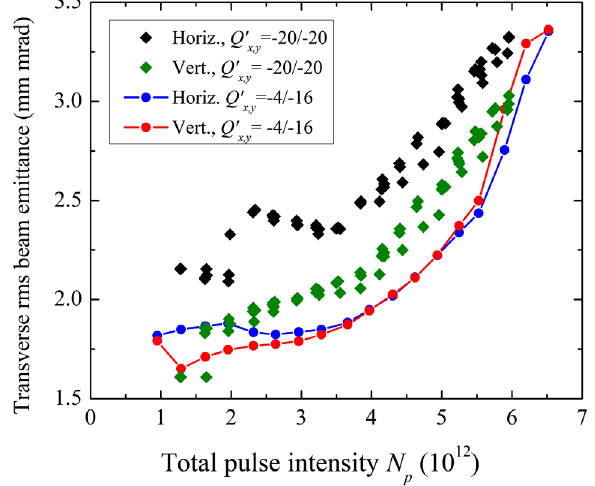
FIG. 12. Booster beam emittance measured by MWs at extraction vs the total proton intensity.